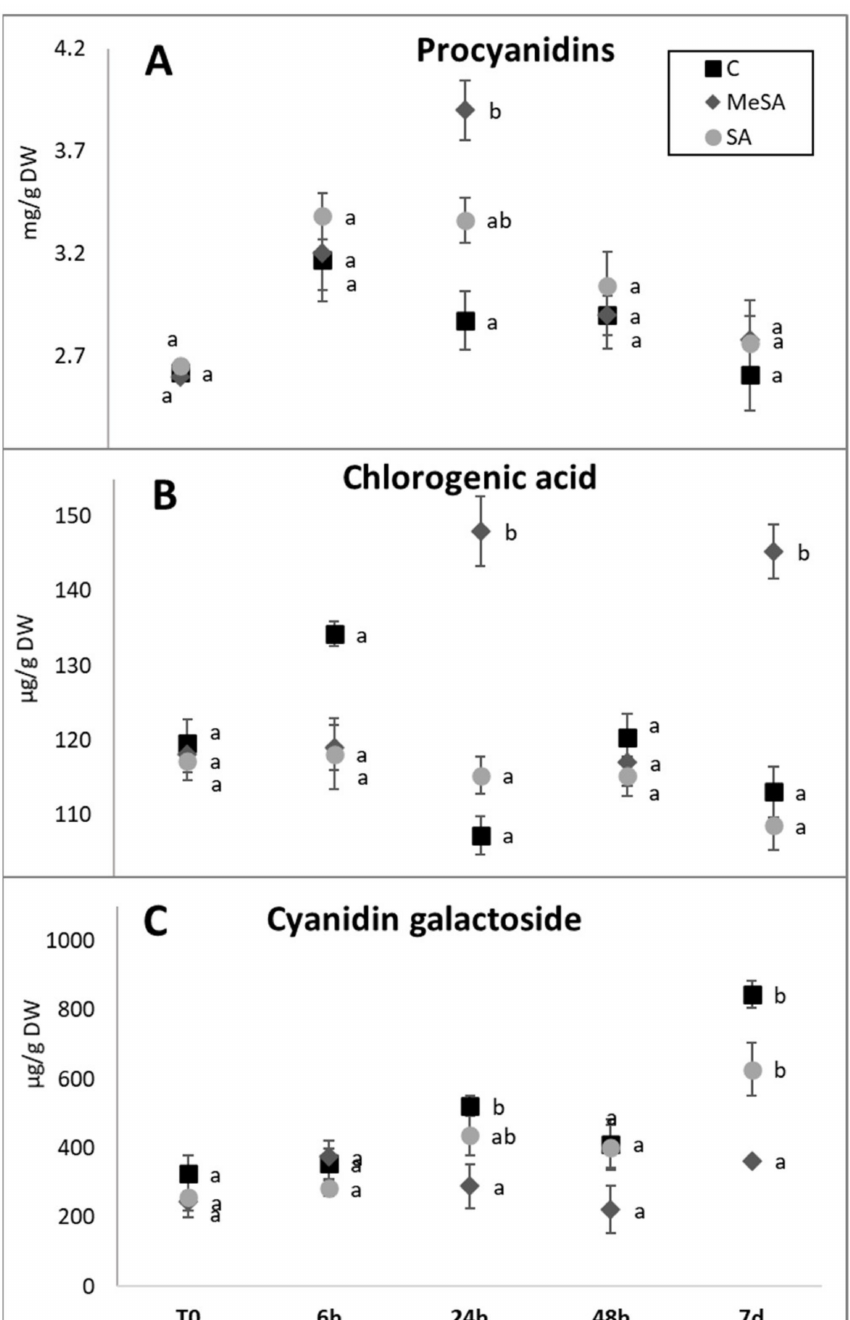
Figure 4. Procyanidins ( A ), chlorogenic acid ( B ), and cyanidin-3- O -galactoside ( C ) levels in apple fruit peel following treatments of apple trees, as control ( C ) and methyl salicylic acid (MeSA) and salicylic acid (SA) treatments at different sampling times after the first spraying (Spray#1). Data are means ± standard error ( n = 10). Different letters indicate significant difference between treatments at each sampling time ( p < 0.05; Duncan